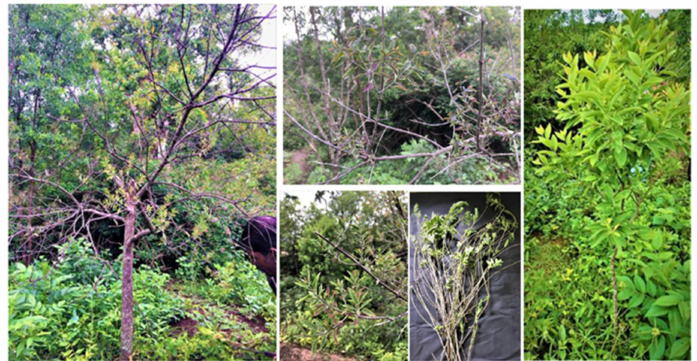
Figure 6. Decline, small and narrow leaves in sandal spike-infected Santalum album (sandal). Right, healthy